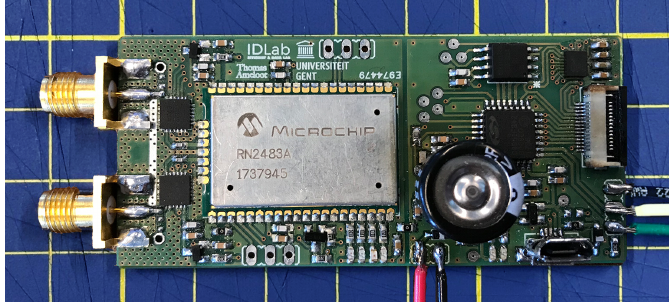
Figure 5. Compact PCB implementation of the wireless sensor node. (One square equals one cm 2